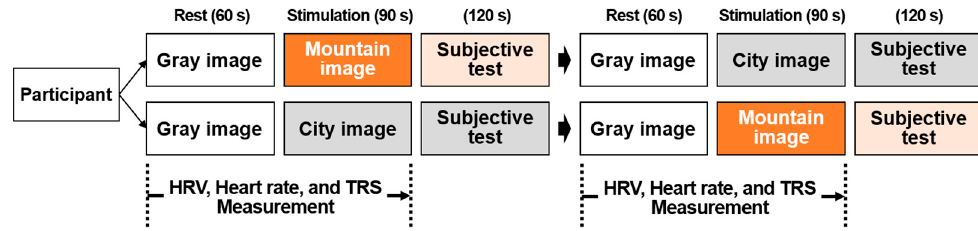
Figure 3. Measurement protocol for visual stimulation with mountain and city landscape images. The orders of mountain and city images were counterbalanced. The study employed a within-participant design.